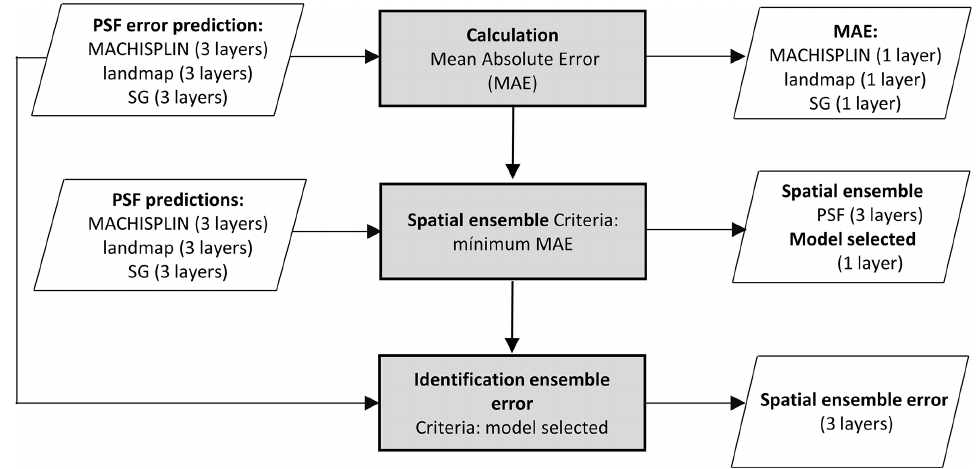
Figure 2. Framework used for generating ensemble maps. PSF means inputs or outputs for clay, sand, and silt.